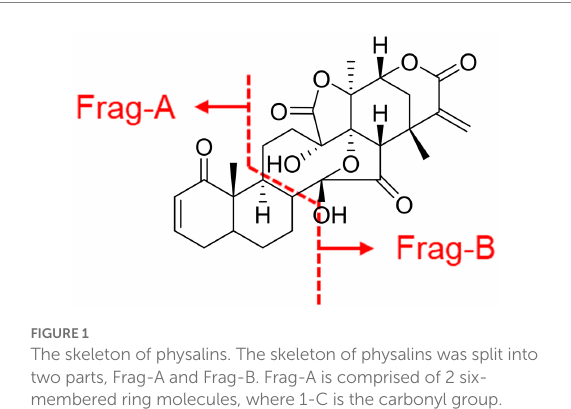
FIGURE 1 The skeleton of physalins. The skeleton of physalins was split into two parts, Frag-A and Frag-B. Frag-A is comprised of 2 six- membered ring molecules, where 1-C is the carbonyl group. Frag-B is comprised of four parts, where 27-C and 14-OH are likely to form rings or annular